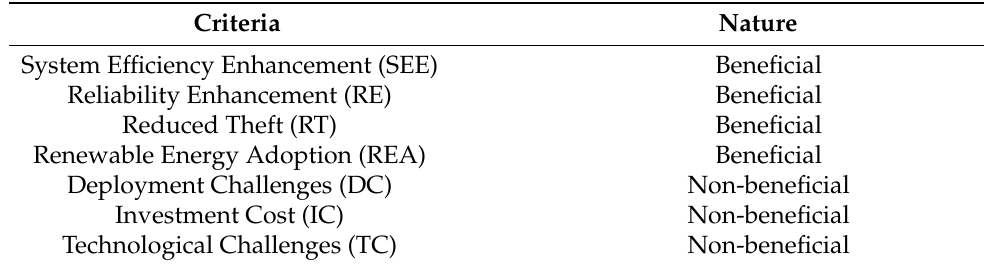
Table 15. The nature of the criteria used in the MCDM analysis.